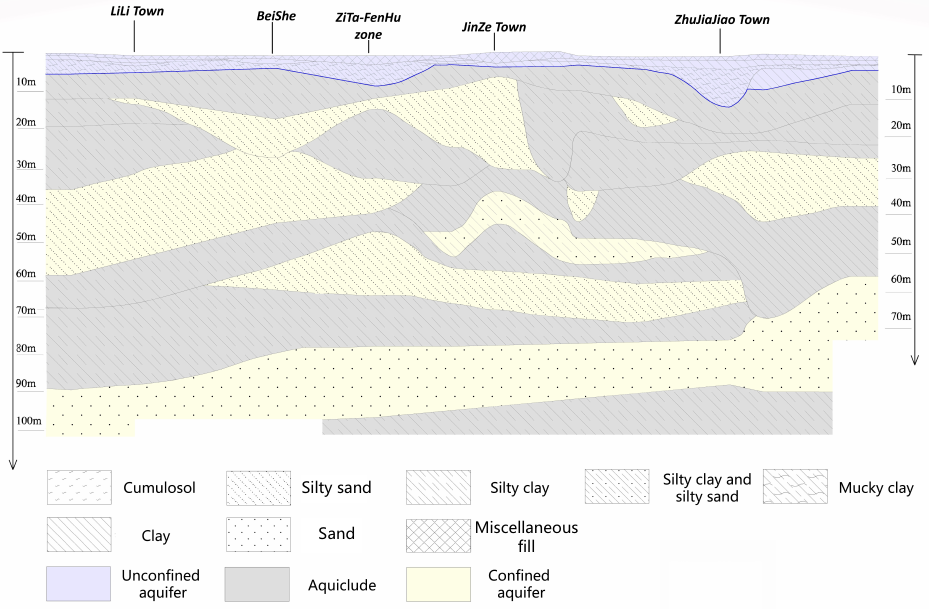
Figure 2. Hydrogeological profile (A-B) of the study